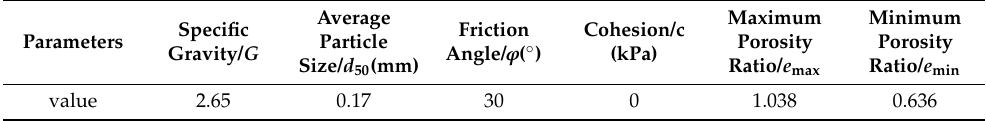
Table 2. Physical parameters of standard